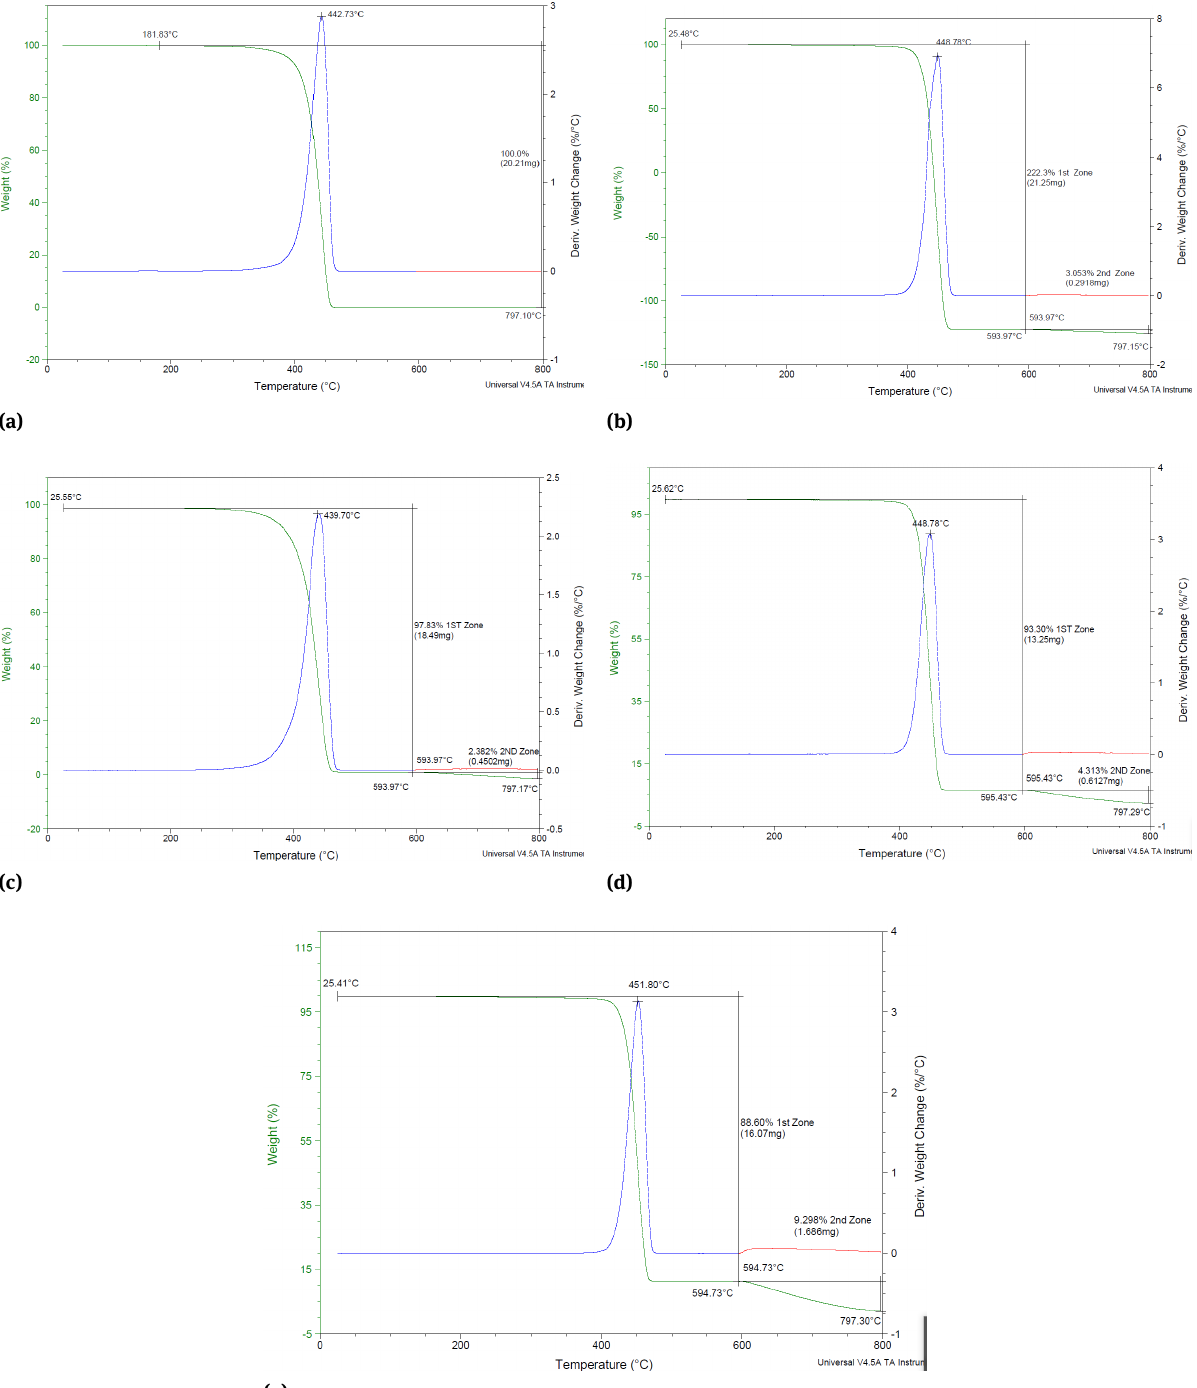
Figure 4: TGA result of (a) 100 wt.% PP, (b) PP/1xGnP/2n-MgO, (c) PP/2.5xGnP/2n-MgO, (d) PP/5xGnP/2n-MgO and (e)